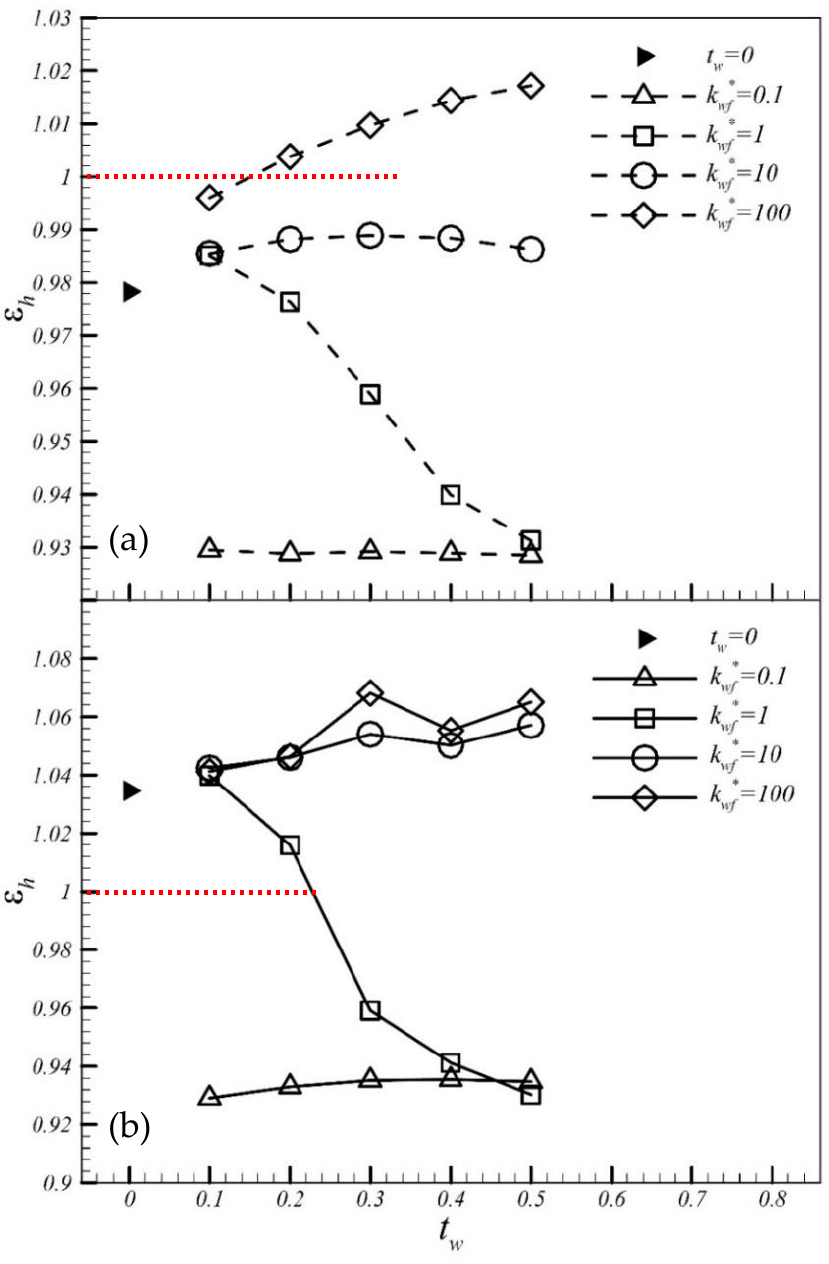
Figure 6. Variation in ε h with t w (top: ( a ) Ra ∗ = 10 10 ; bottom: ( b ) Ra ∗ = 10 11 ) ( AR = 1, 𝑙 ℎ∗ = 0.8, 𝑆𝑏 ∗ = 0.6, 𝑆𝑡𝑒 ∗ = 0.1, and 𝑐 𝑧 = 2, 𝑣 = 10%).